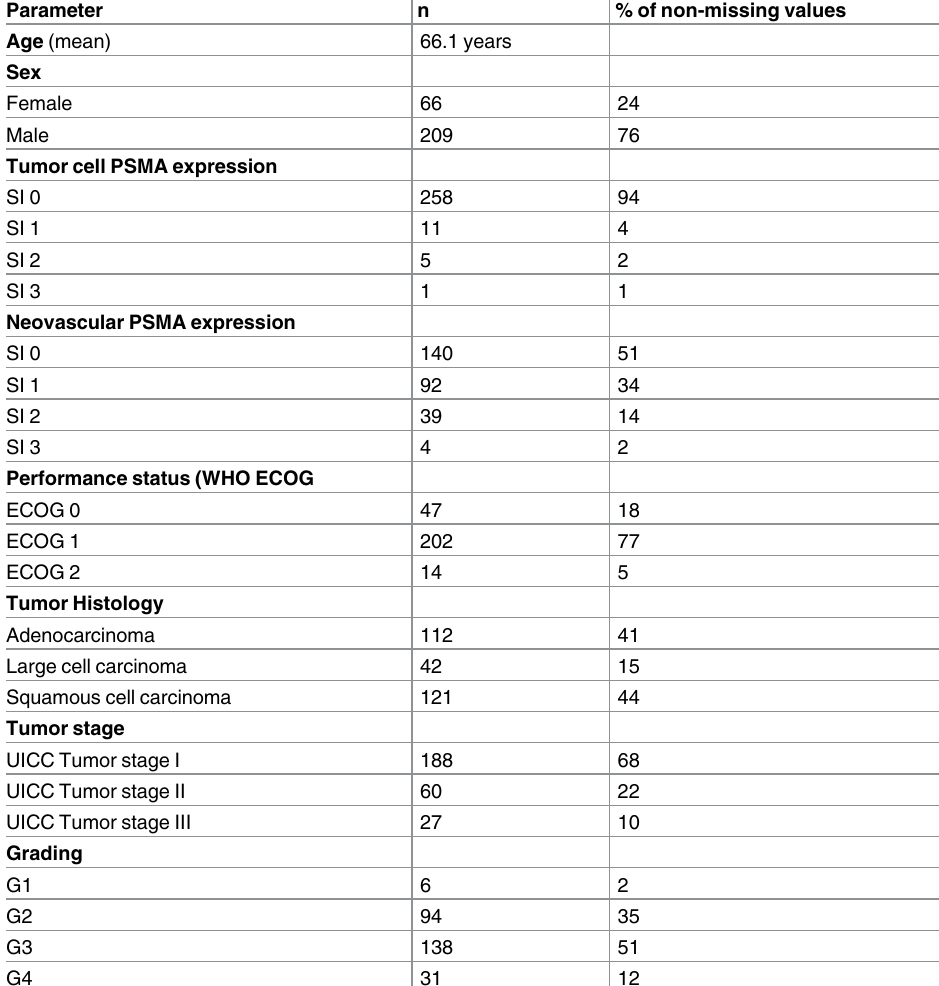
Table 1. Baseline characteristics of the NSCLC study